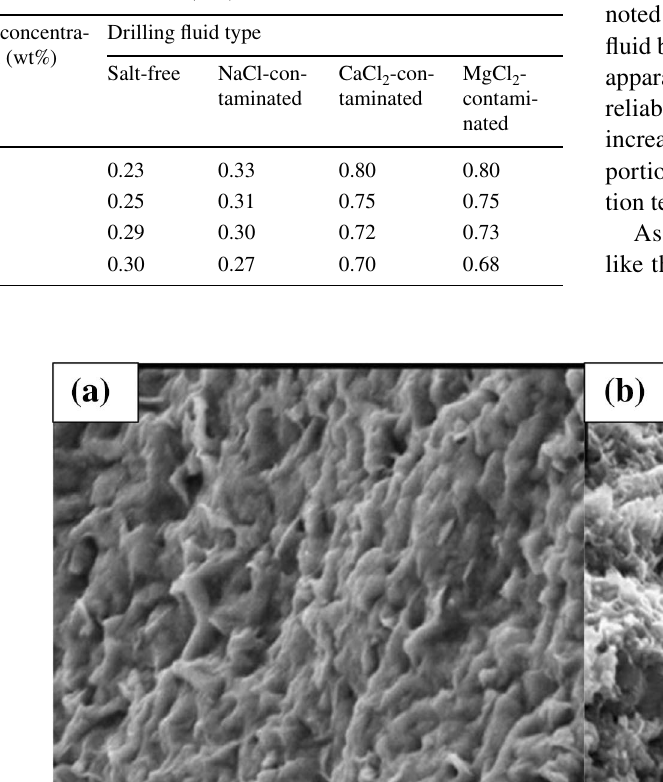
3 O 4 , b in the presence of Fe 3 O